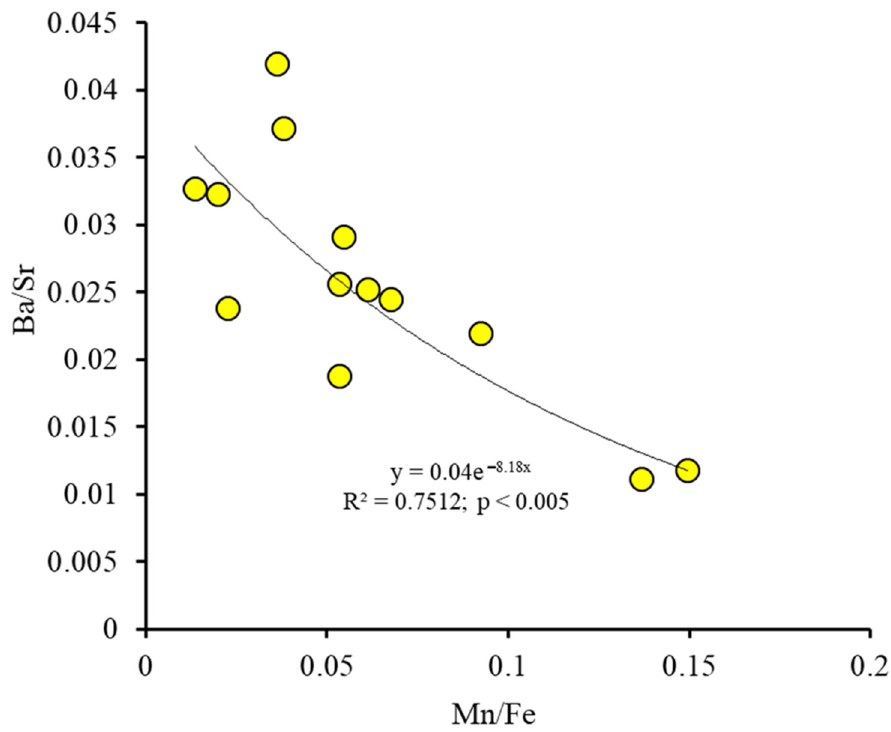
Figure 9. Relationship between Mn/Fe (oxygen) and Ba/Sr